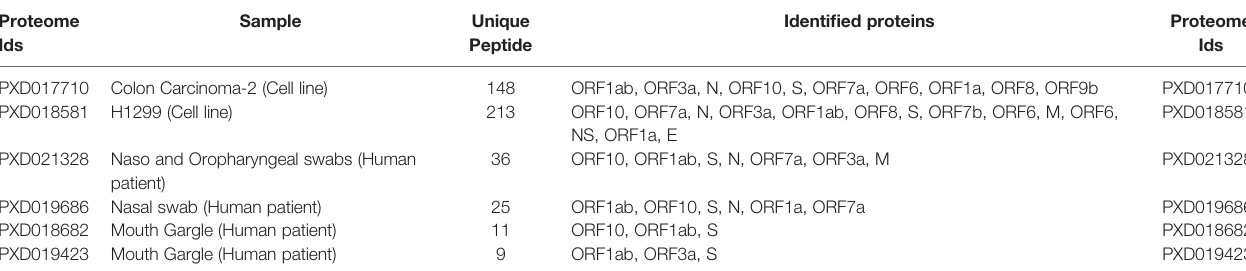
TABLE 1 | Summary of studied proteomes, number of uniquely identi fi ed peptides, and reference proteins. Proteome